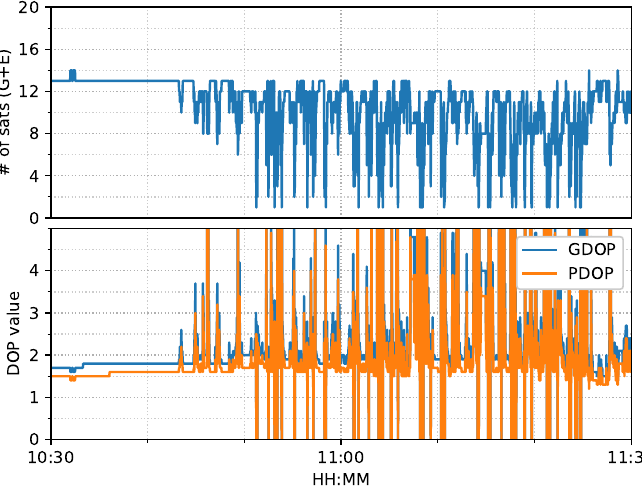
Figure 14. GNSS satellite information of complex road test on 11 February